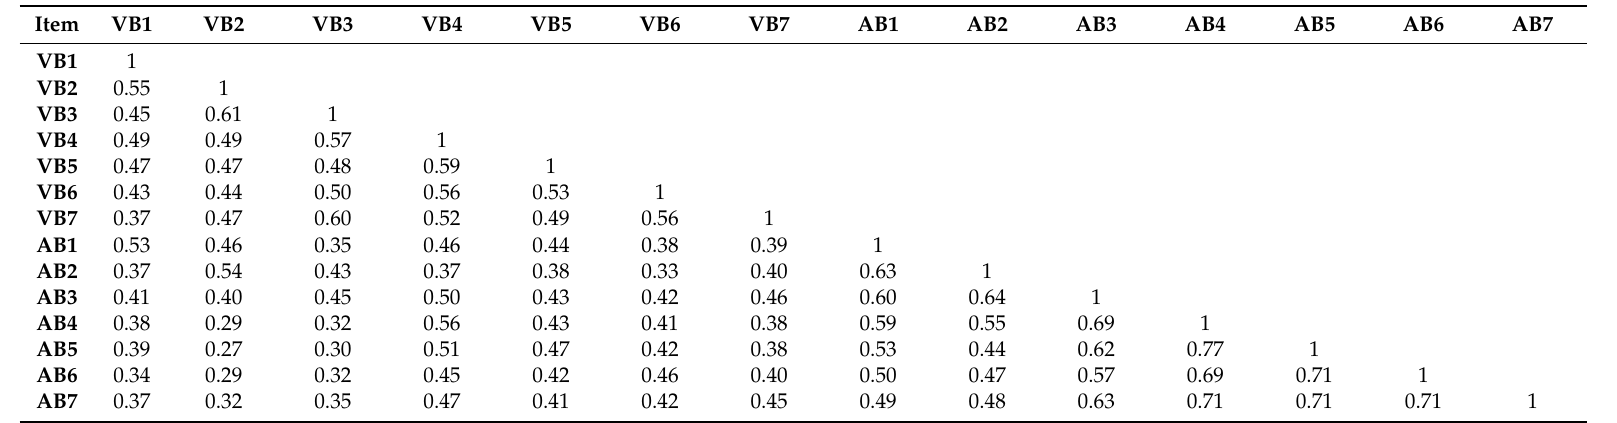
Table 2. Matrix of EBIPQ polychoric